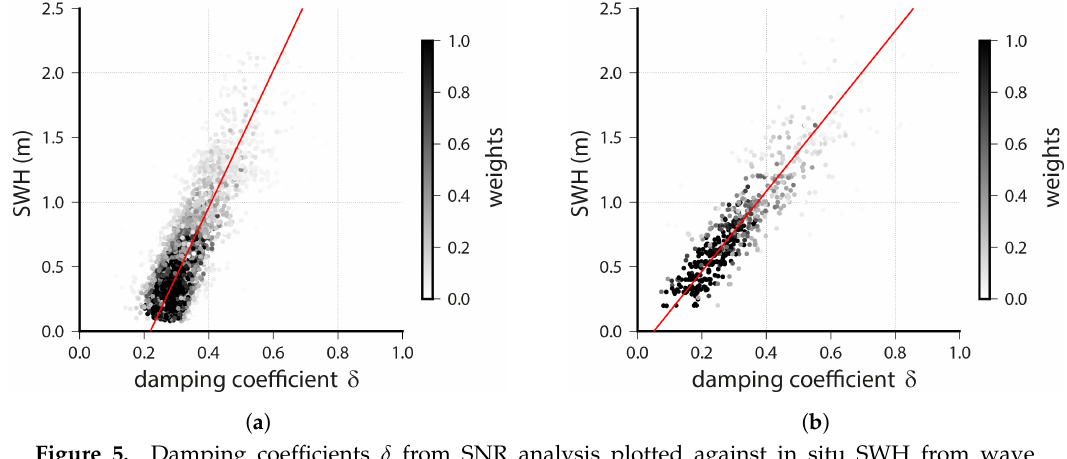
Figure 5. Damping coefficients δ from SNR analysis plotted against in situ SWH from wave buoys. Shading with respect to their final weights in the robust adjustment. Estimated first degree polynomial (red). ( a ) Data from the static antenna. ( b ) Data from the ship-based antenna. Table 2. Standard deviation of unit weight and estimated parameters of the linear